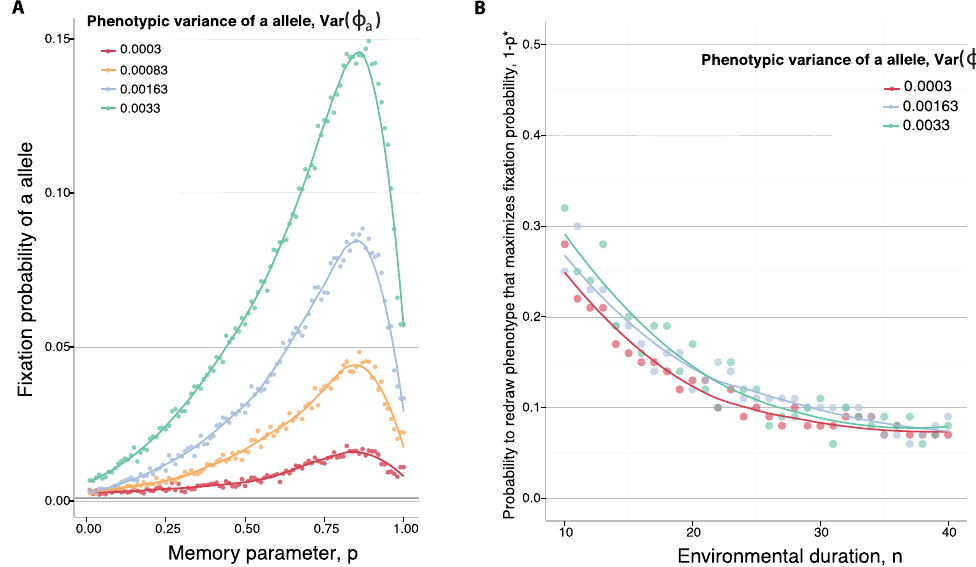
Figure 4. Fixation of a phenotypically variable allele in a periodic environment. ( A ) The phenotypic memory p , on the x -axis, is plotted against the fixation probability of a novel a allele in a population of size N = 1000. Different colors represent different variances of the a phenotype, Var ( Φ a ), as indicated. The duration of one environmental period is n = 20. The first environment is always E 1 , in this figure. ( B ) The environmental duration is plotted on the x -axis, against 1 − p * , where p * is the value of phenotypic memory that maximizes the probability of fixation in a population of size N = 1000. Different colors represent different phenotypic variances of the a allele, Var ( Φ a ), as indicated. The curves show cubic spline fits to the simulated